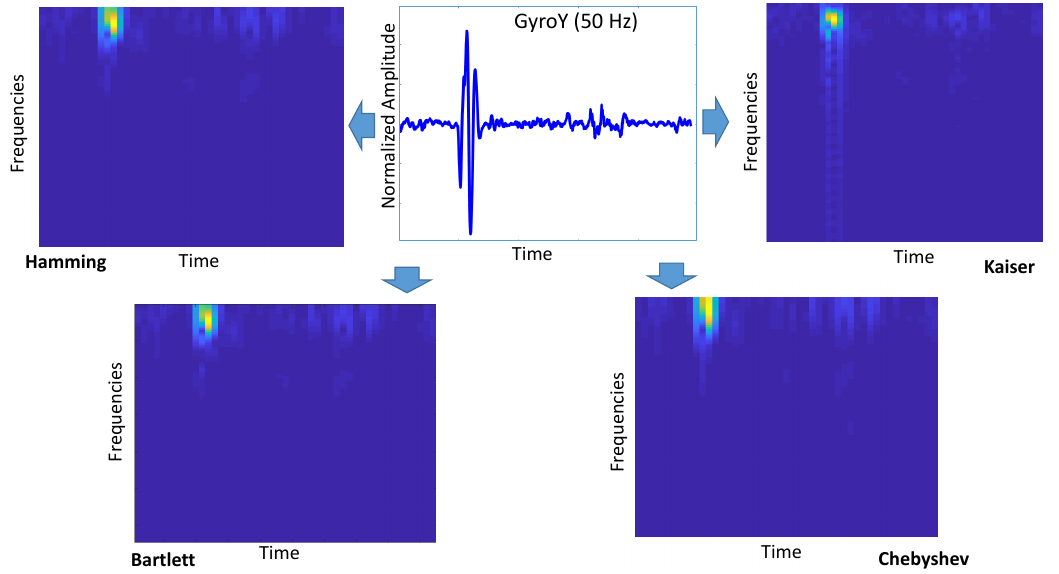
Figure 8. Application of the spectrogram to the Gyroscope Y (GyroY) output from the